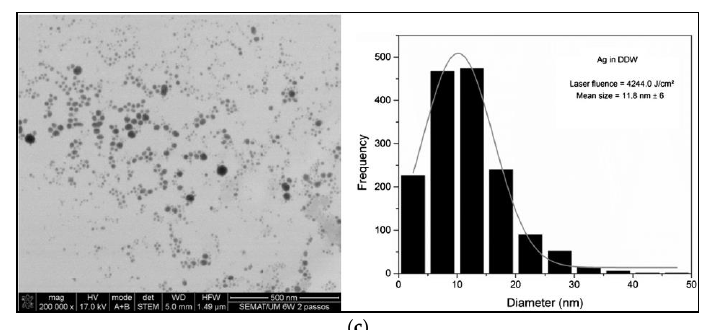
Figure 11. STEM images and corresponding histograms of silver colloidal nanoparticles prepared by laser ablation at different laser fluences ( a ) 2122.2 J/cm 2 ; ( b ) 3183.3 J/cm 2 and ( c ) 4244.0 J/cm 2 . Reprinted from [165], with permission from Elsevier.